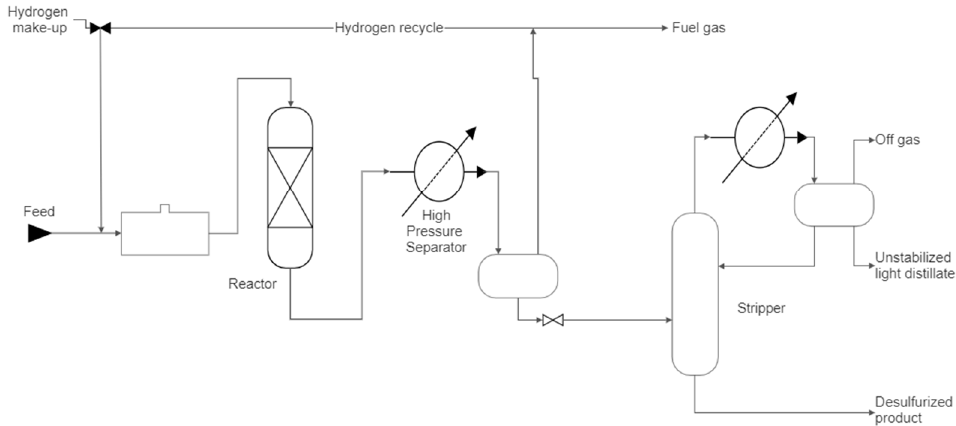
Figure 1. Hydrodesulfurization flow diagram.